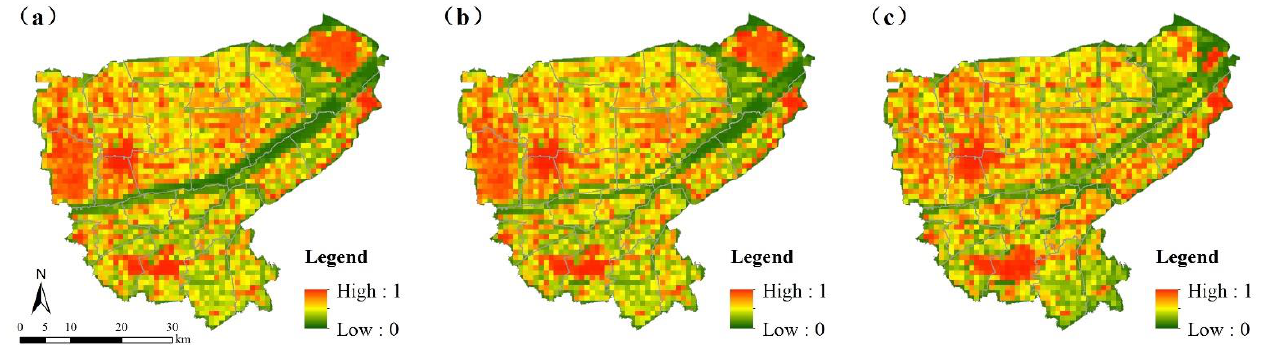
Figure 8. The spatial distribution of standardized human disturbance in the study area for three years: ( a ) 2009; ( b ) 2014; ( c ) 2020.